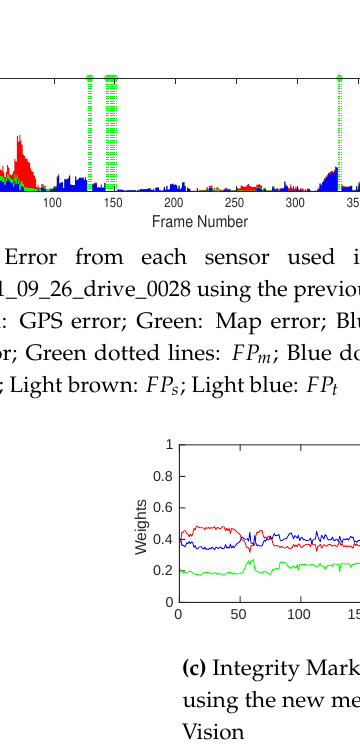
Figure 6. Comparison results of dataset 2011_09_26_drive _0028.